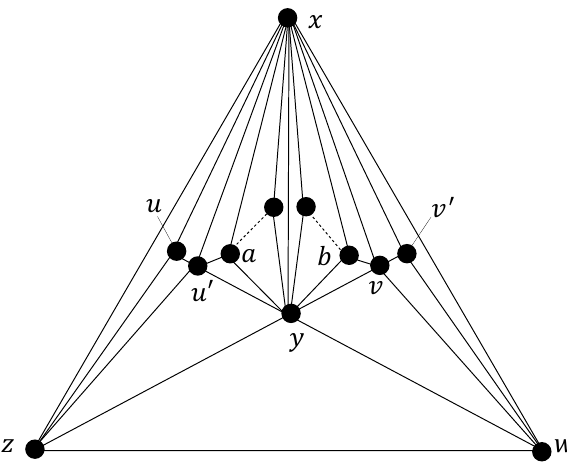
Figure 1: A triangulation G on the sphere with guarding number 4 and